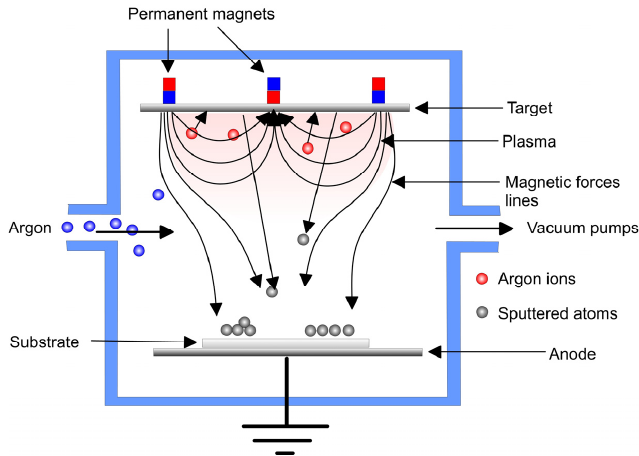
Figure 8. Schematic representation of magnetron sputtering PVD process for deposition of thin